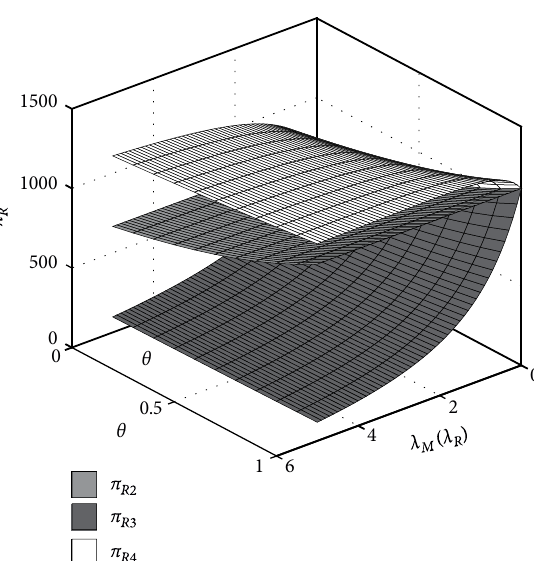
Figure 5: The effects of 𝜃 , 𝜆